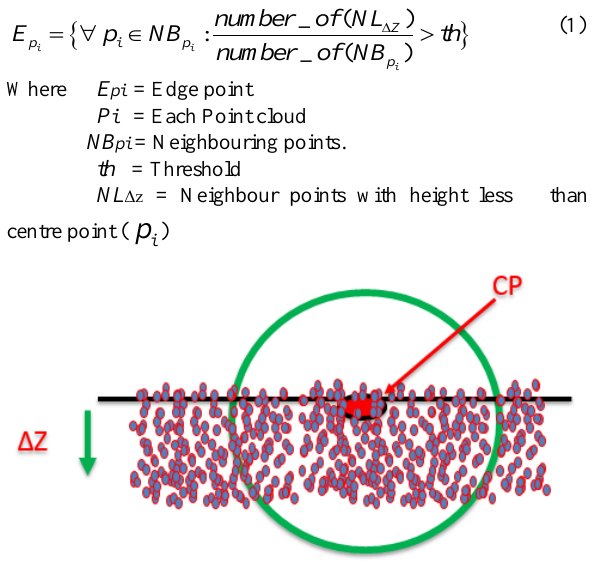
Figure 1: The range search criteria